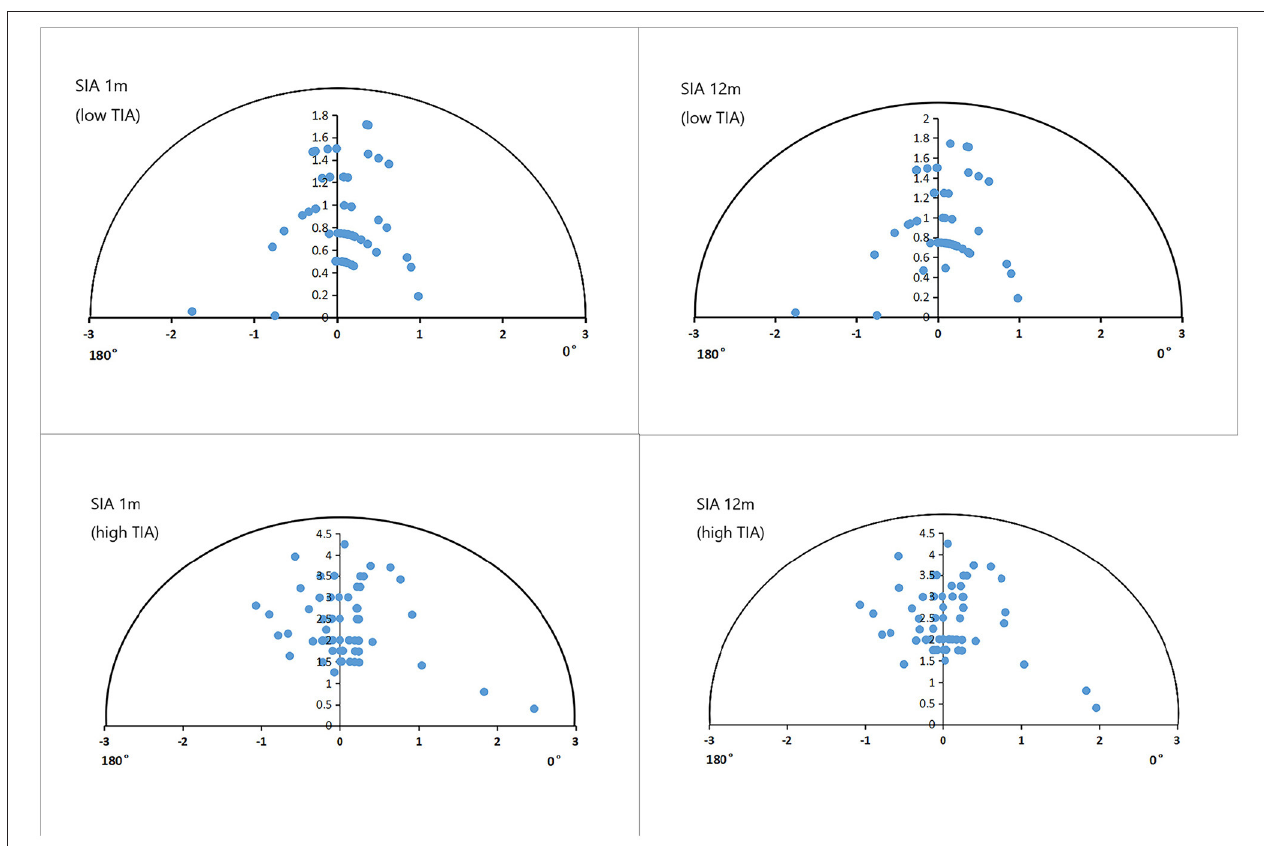
FIGURE 4 | Single-angle polar plots of refractive SIA in the low- and high-TIA groups. ORA, ocular residual astigmatism; SIA, surgical-induced astigmatism; TIA, target-induced astigmatism.